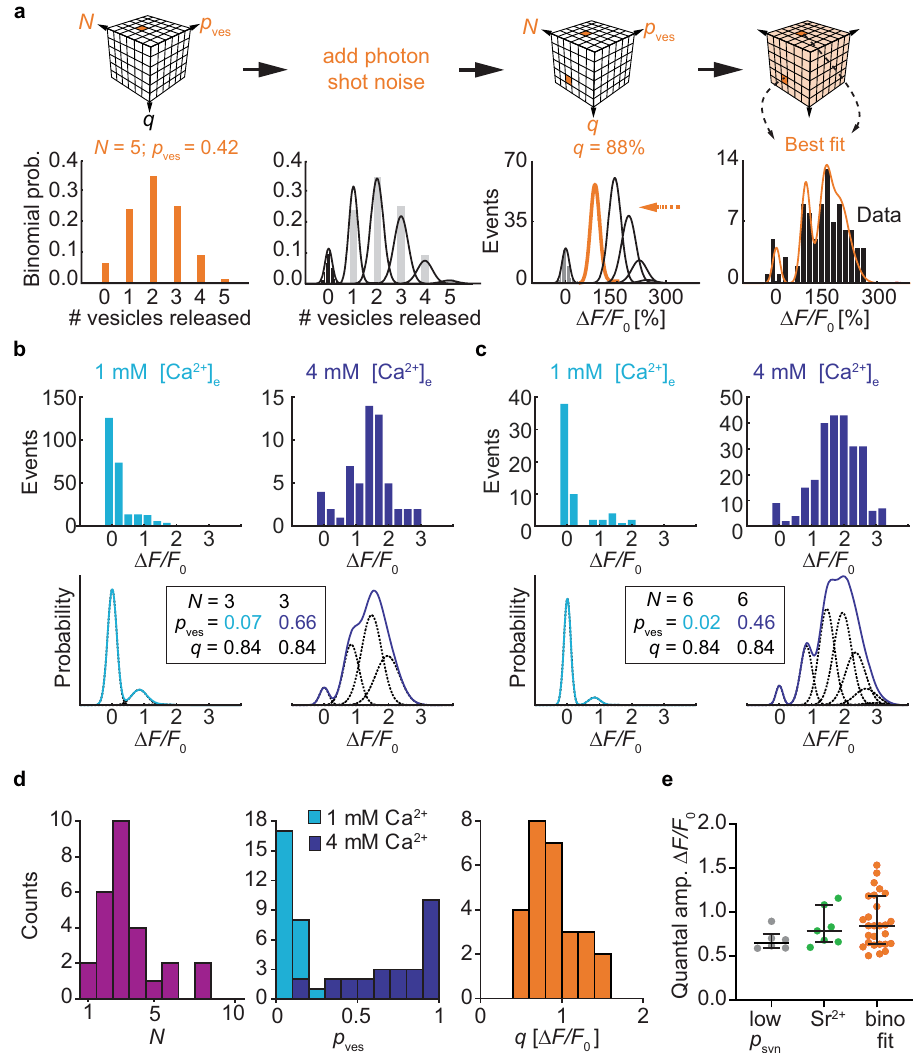
Fig.6|Extracting N , p ves ,and q ofSchaffercollateralsynapsesusingabinomial model. a Extracting quantal parameters by exhaustive search. For every combi- nation of N and p ves , the binomial probabilities of the possible outcomes were calculated (here: N =5 vesicles and p ves =0.42). Without stimulation, amplitudes were normally distributed around zero (black histogram). The width of this noise distribution was used to determine the width of the expected Gaussian probability density functions. A chosen quantal amplitude q (here: 88% Δ F / F 0 ) and iGluSnFR saturation function ( B max =6 Δ F / F 0 , orange arrow) sets the spacing of the Gaus- sians. The resulting probability density function (sum of the Gaussians) was com- pared to the measured amplitude distribution (black bars, recorded in 2mM [Ca 2+ ] e ). The root mean square (RMS) error was calculated and the best fi t (shown here) was selected. b , c Single bouton response distributions recorded in 1mM [Ca 2+ ] e and 4mM [Ca 2+ ] e . Two examples from two different slice cultures. The binomial fi tting procedure was applied to both histograms, searching for the best